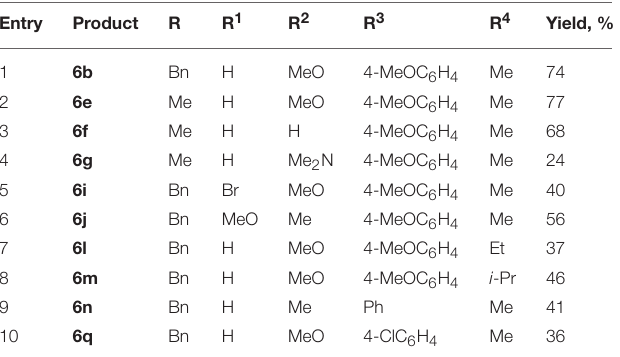
TABLE 3 | Consecutive four-component synthesis of imidates 6 a .